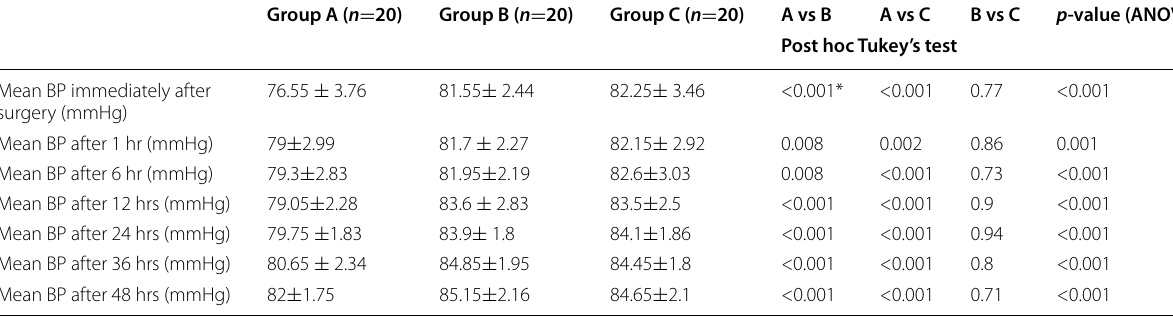
Table 5 Comparison between the three groups as regard the vital data